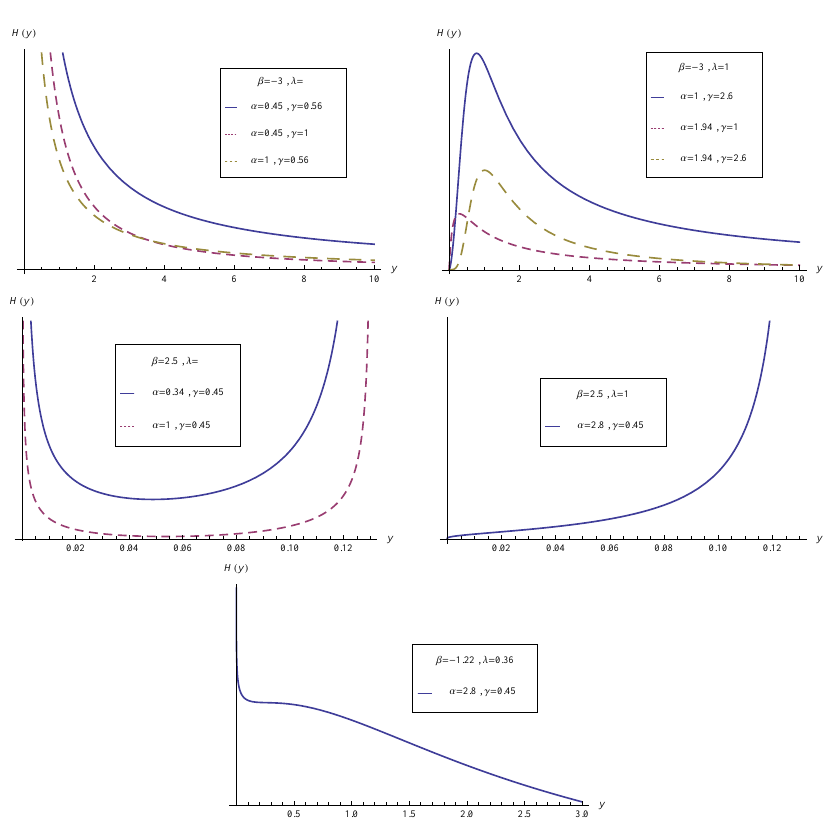
Figure 2 – The hazard rate of the EEW for different values of α , β and γ with λ = 1. T HEOREM 1. If γ = 1 and β < 0 , then